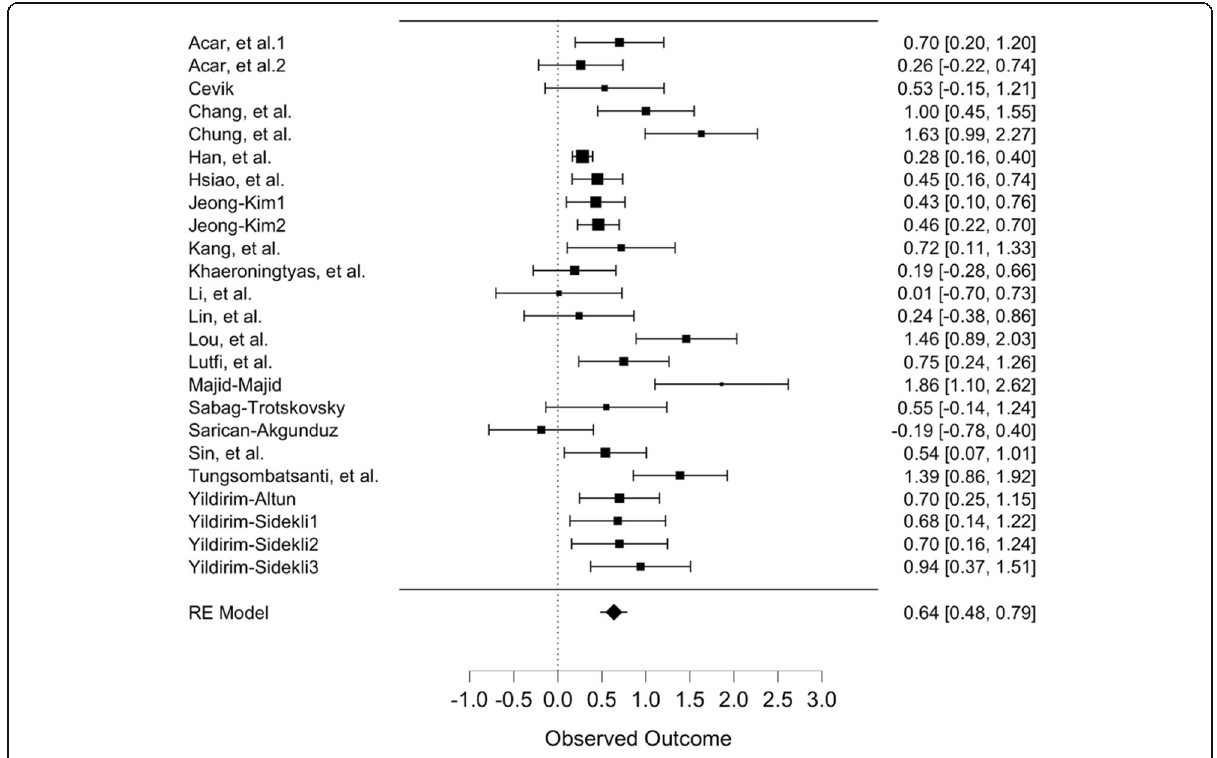
Fig. 2 A forest plot of students ’ academic learning achievement (ALA)